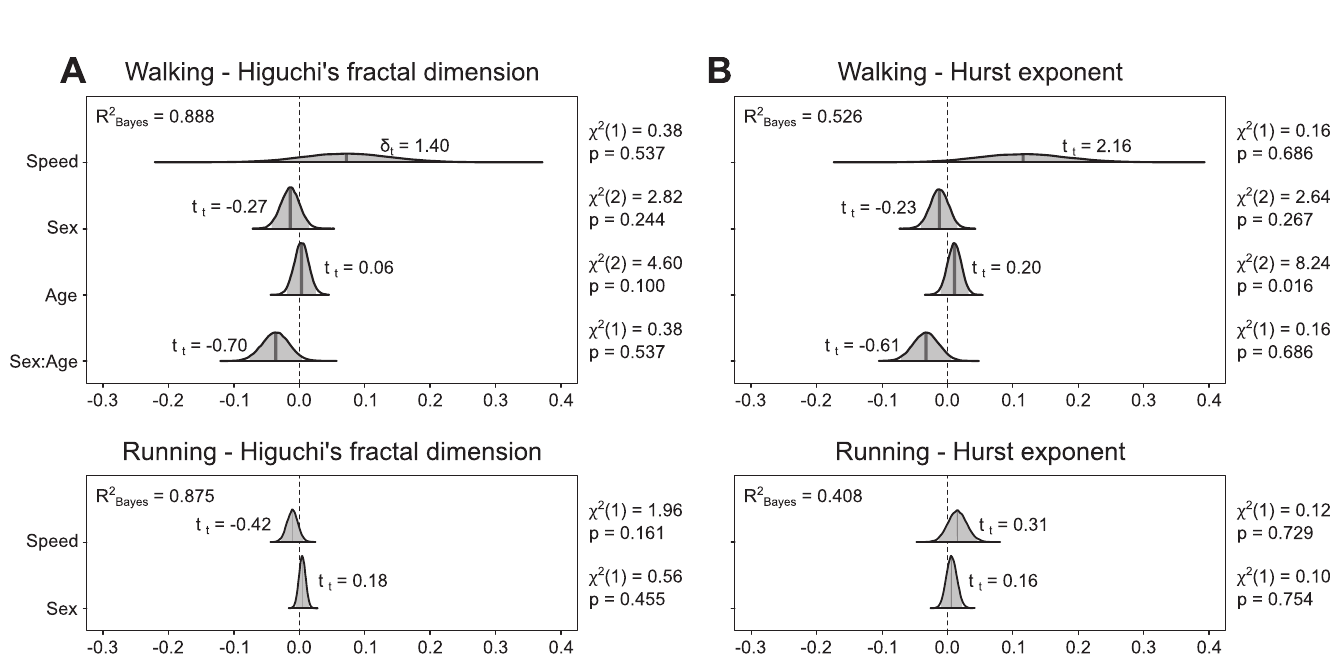
Fig 8. Posterior 95% credible intervals for the estimated differences in Higuchi’s fractal dimension and Hurst exponent. (A) The 95% credible intervals and their probability distributions (shaded areas) describe the effects and interaction of sex and age (with locomotion speed as a covariate) on the Higuchi’s fractal dimension. Positive values indicate higher fractal dimension in females than in males and in older than in younger adults. Effect size in the style of Hedges (i.e., considering all the variance sources in the model) are shown on the graphs and called δ t . A Bayesian equivalent of R 2 (here R 2 Bayes ) describes how well the model fits the data. Next to each estimation, the χ 2 and p-values resulting from a frequentist linear mixed model analysis are reported as additional information. (B) The same as in panel (A), but for the Hurst exponent.